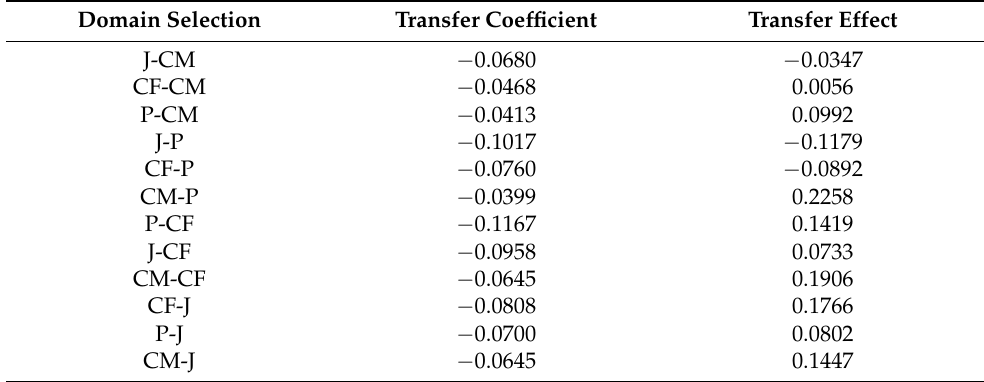
Table 4. The effect of the transfer coefficient.